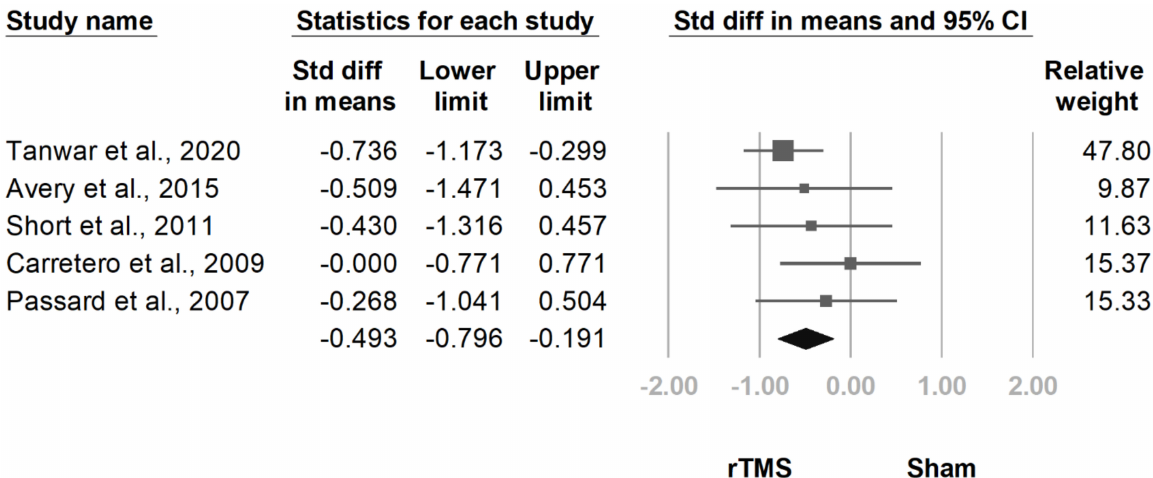
Figure 17. Forest plot of standardized mean differences in Hamilton Depression Rating Scale after treatment. Squares indicate effect sizes of individual studies, lines indicate 95% CI, and diamond indicates the summarized effect size.